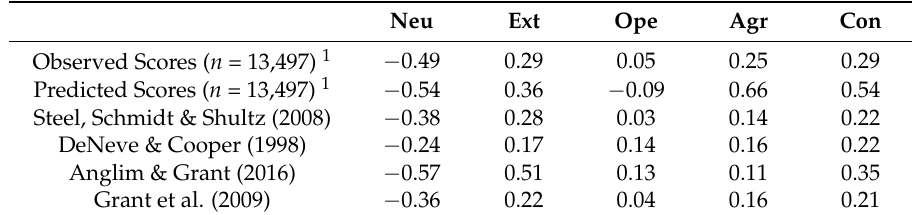
Table 5. Correlations from the literature: FFM Traits with